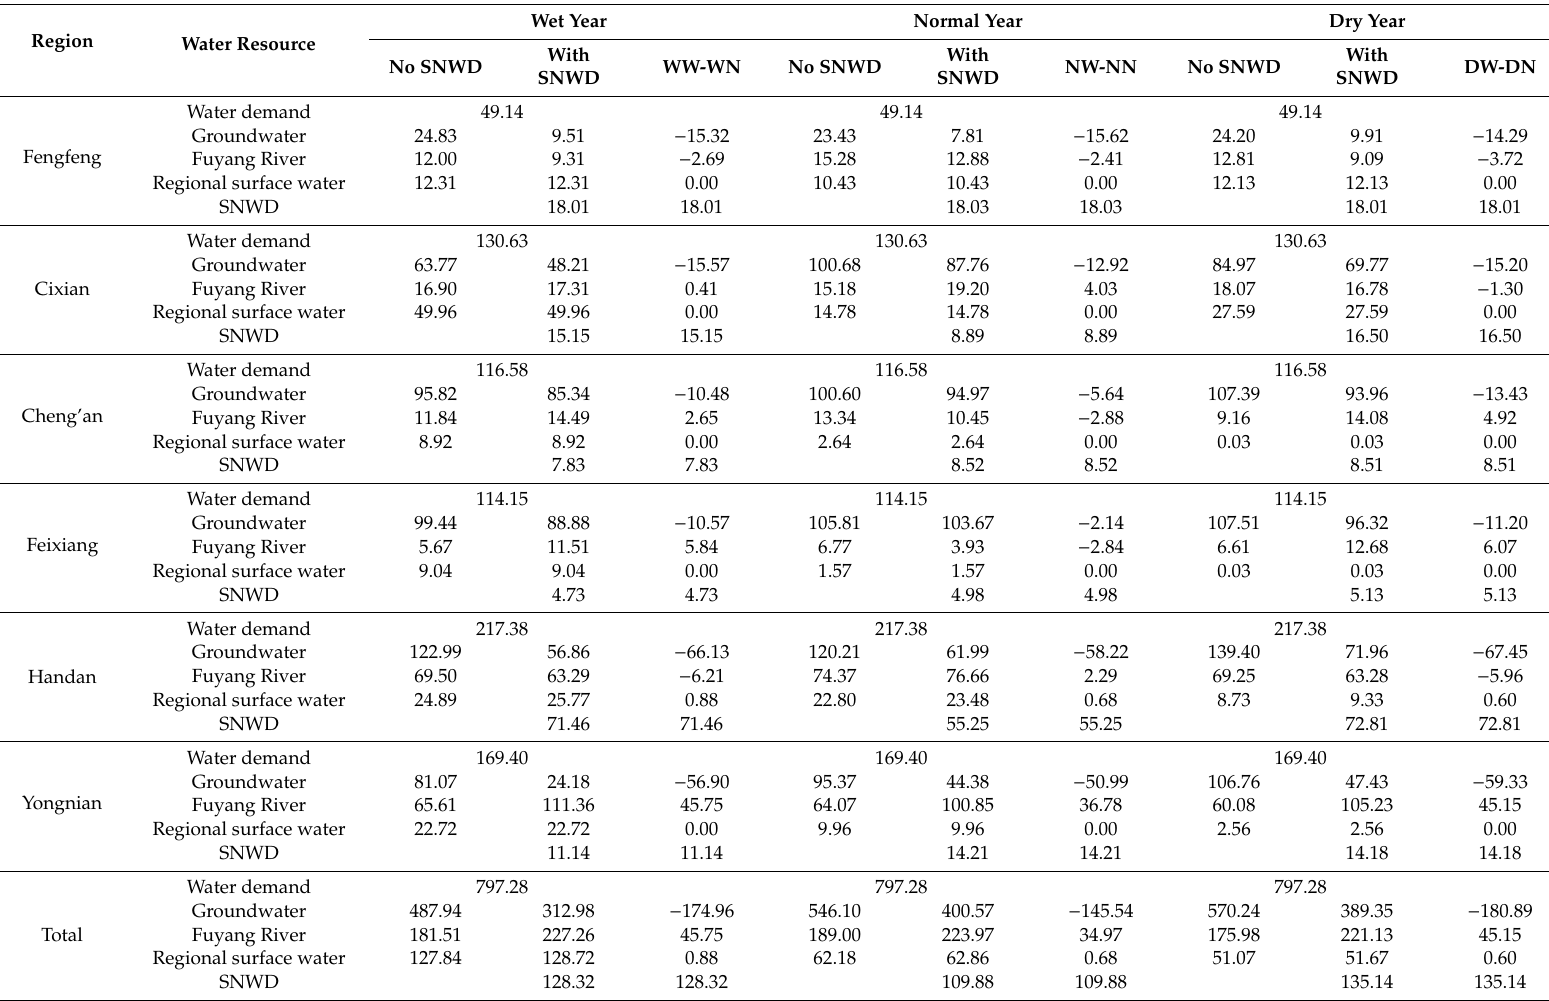
Table 2. Water demand and supply of each administrative area (Unit 10 6 m 3